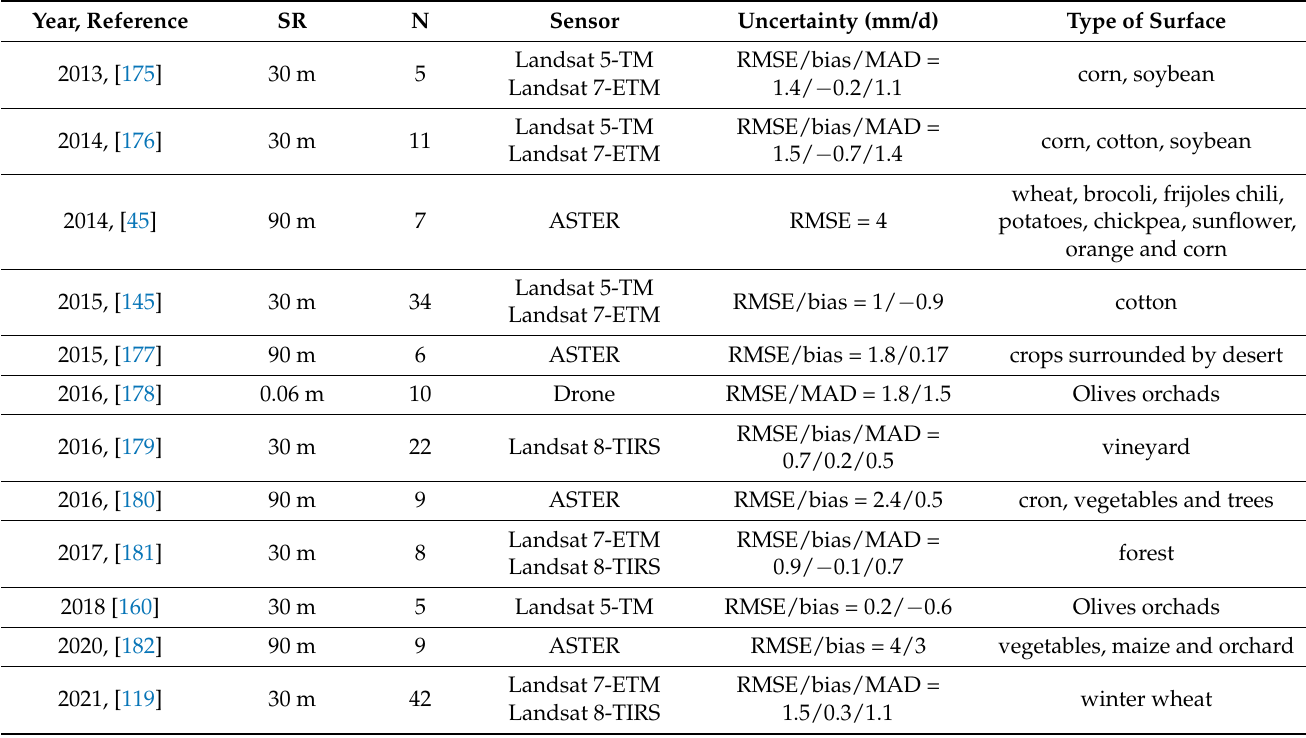
Table 7. Same as Table VI but for studies dated from 2013 to